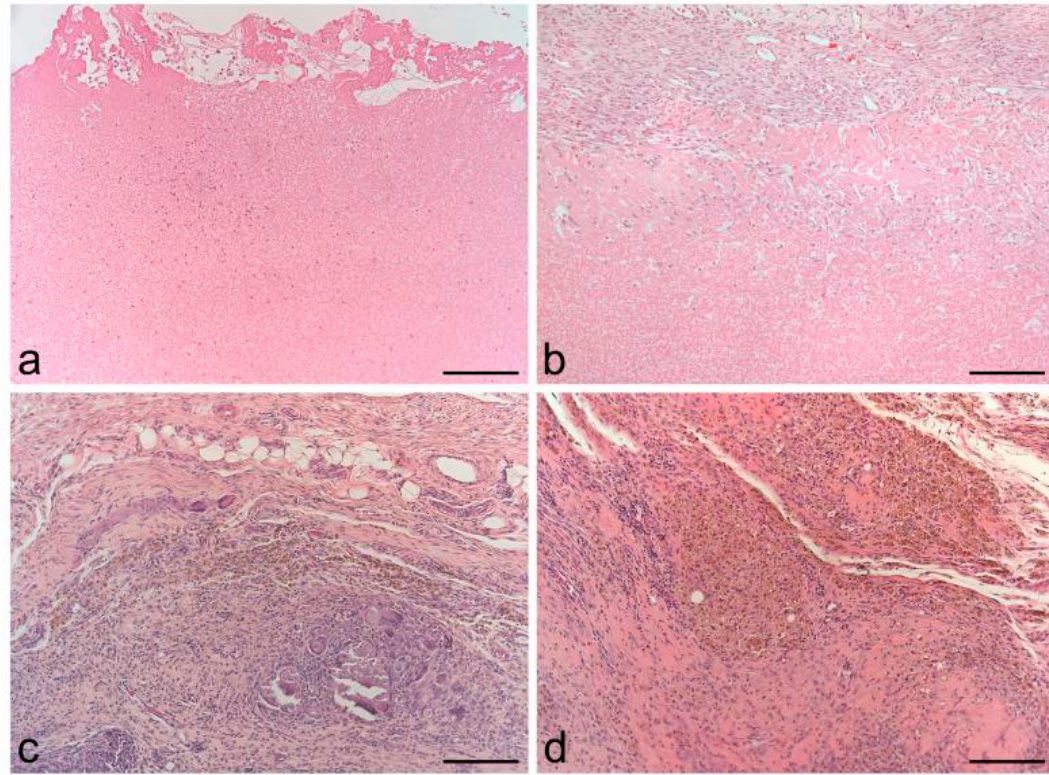
Figure 3. Hematoxylin and Eosin staining of the CLP-MB after 4 ( a ), 7 ( b ), 14 ( c ) and 21 ( d ) days of subcutaneous implantation into the dorsal region of athymic rats. A progressive reabsorption of the fibrin matrix is shown; in ( c , d ) the membranes are not easily detectable due to the almost complete biodegradation. Scale bars: 37.5 µm.